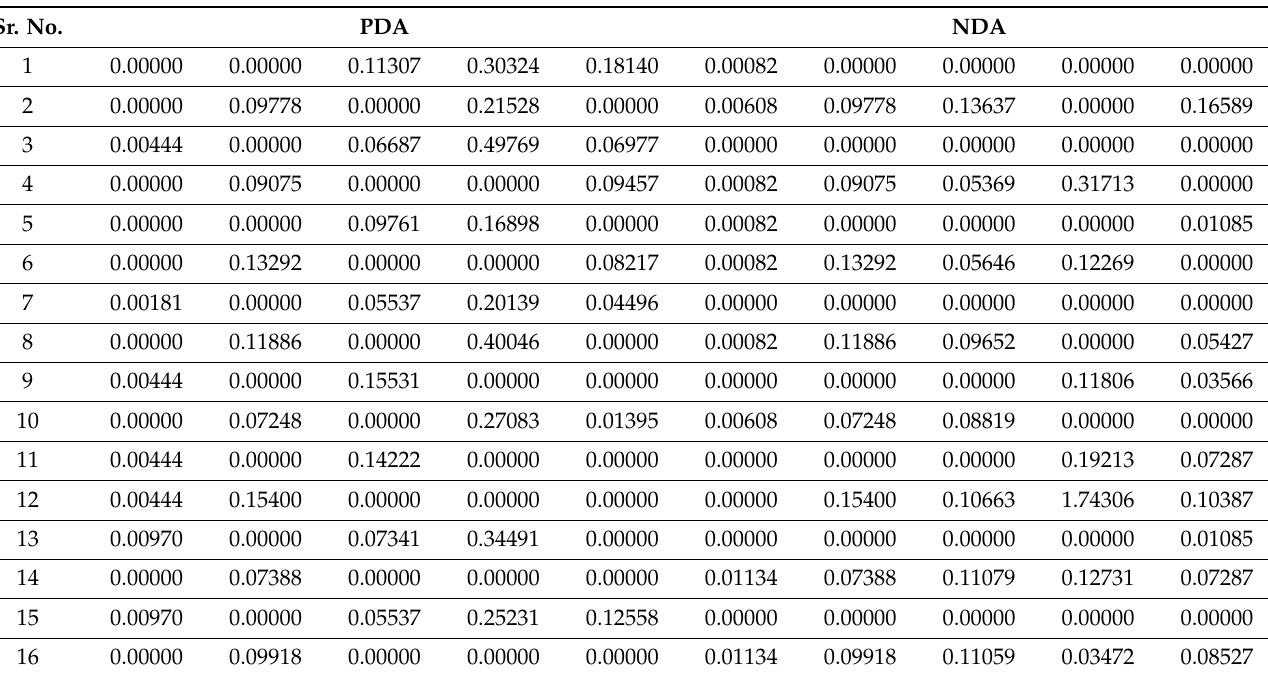
Table 9. Computation of PDA and NDA.